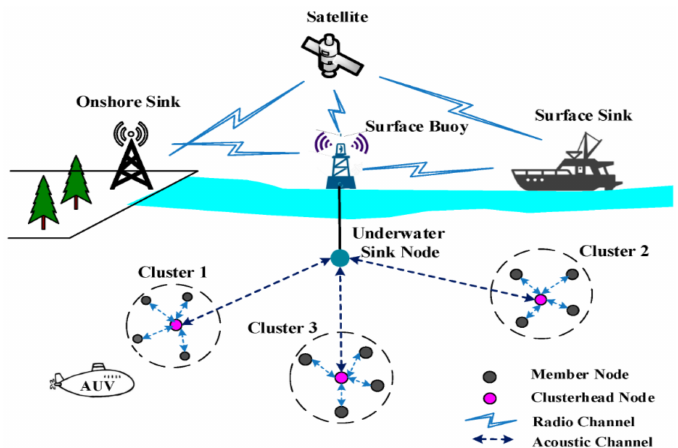
Figure 1. Basic clustering process in underwater wireless sensor